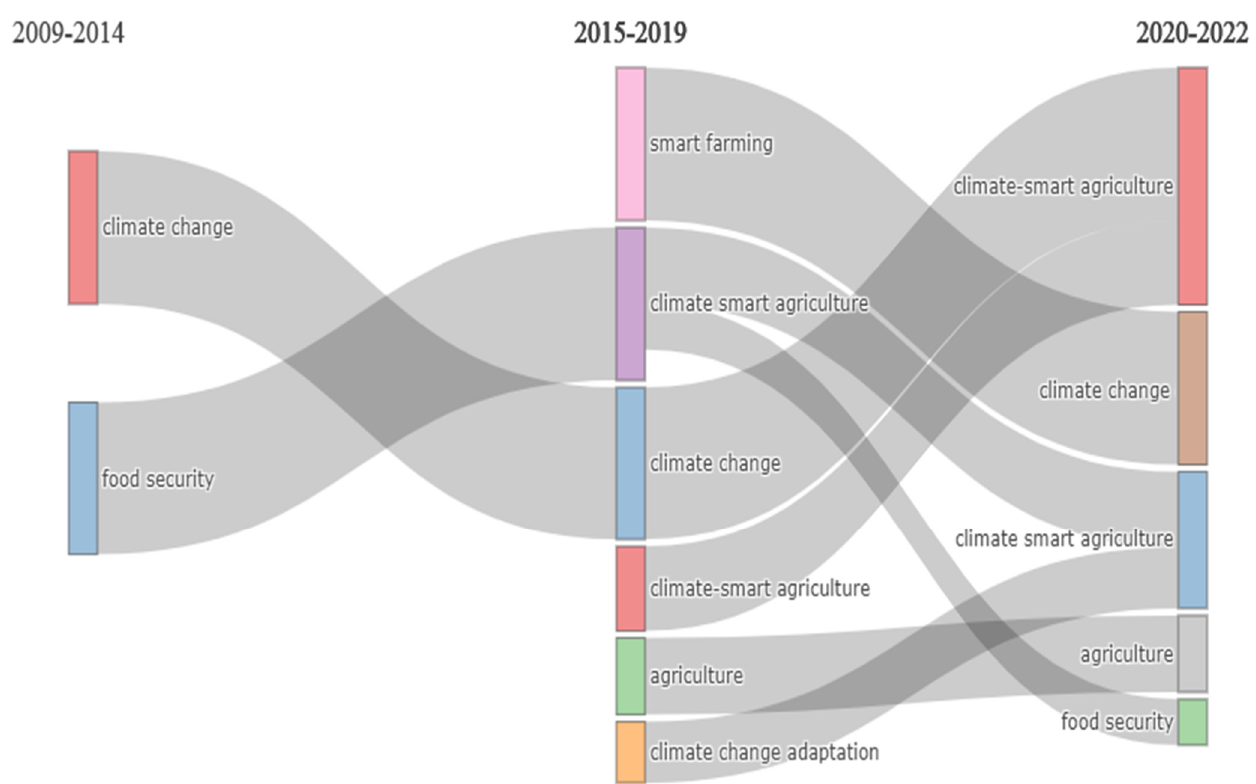
Figure 7. Thematic evolution based on word occurrences within 2009 - 2022.